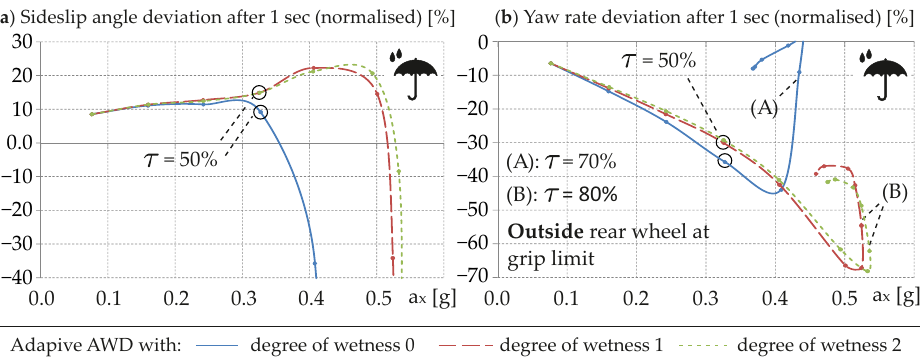
Figure 12. “Power On Cornering“ maneuver ( R = 60m , a y 0 = 6m/s 2 ) on wet road ( µ max = 0.6): ( a ) sideslip angle difference after 1s; ( b ) Yaw rate difference after